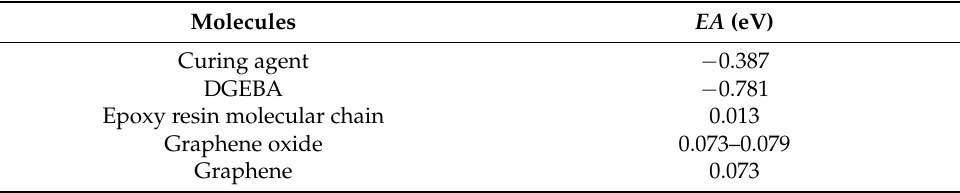
Table 1. EA of different molecules.